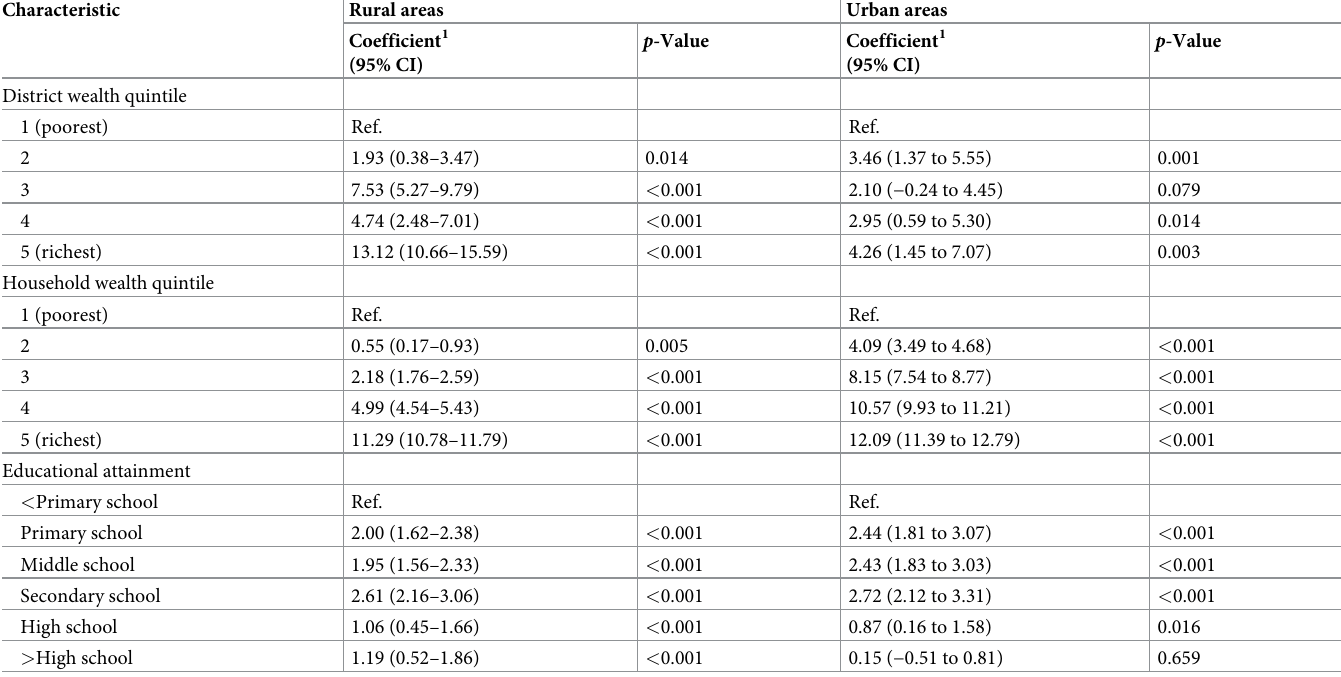
Table 3. Multivariable linear regression of the natural logarithm of 10-year cardiovascular disease risk on district wealth quintile and individual-level sociodemo- graphic